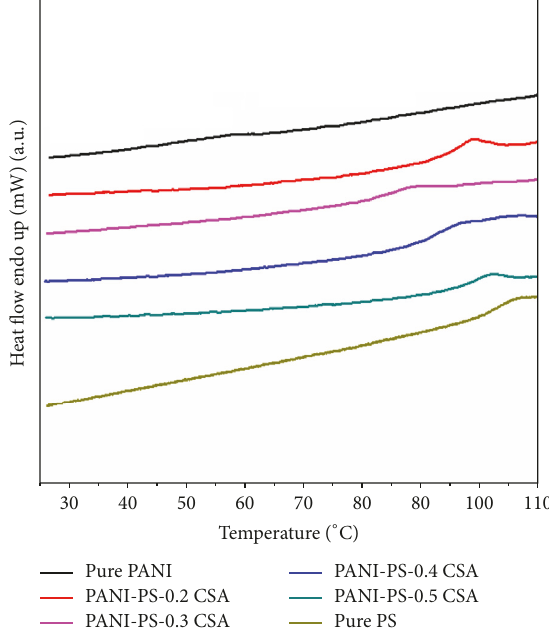
Figure 8: DSC analysis of the pure PANI and PANI-PS